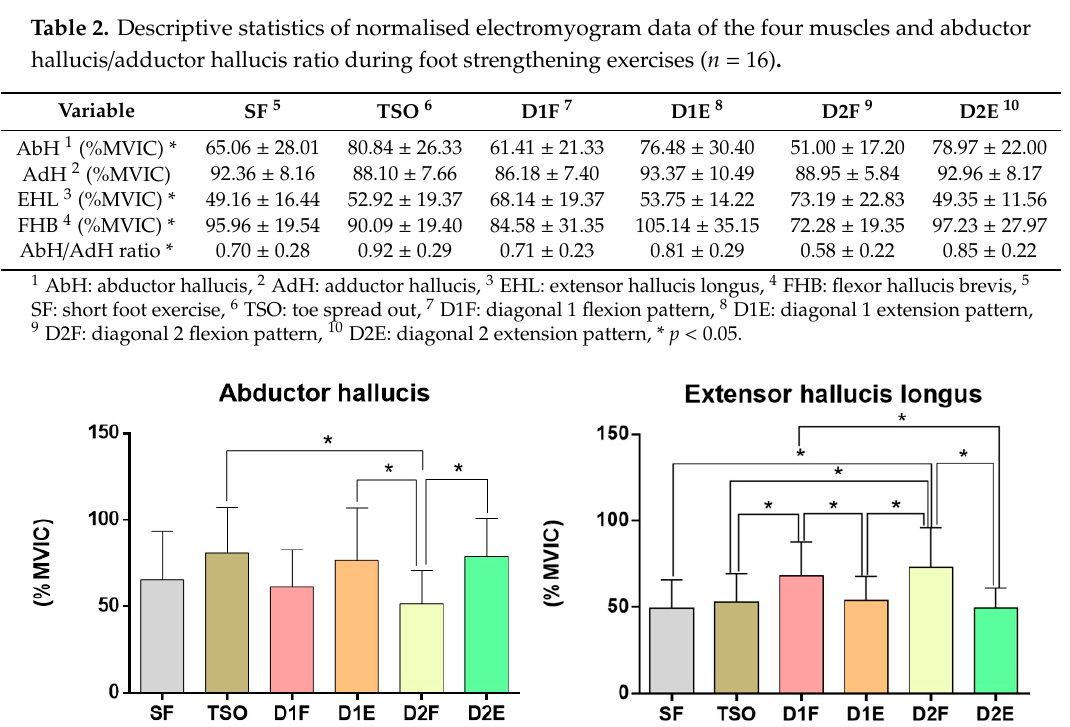
Table 2. Descriptive statistics of normalised electromyogram data of the four muscles and abductor hallucis/adductor hallucis ratio during foot strengthening exercises ( n = 16) .